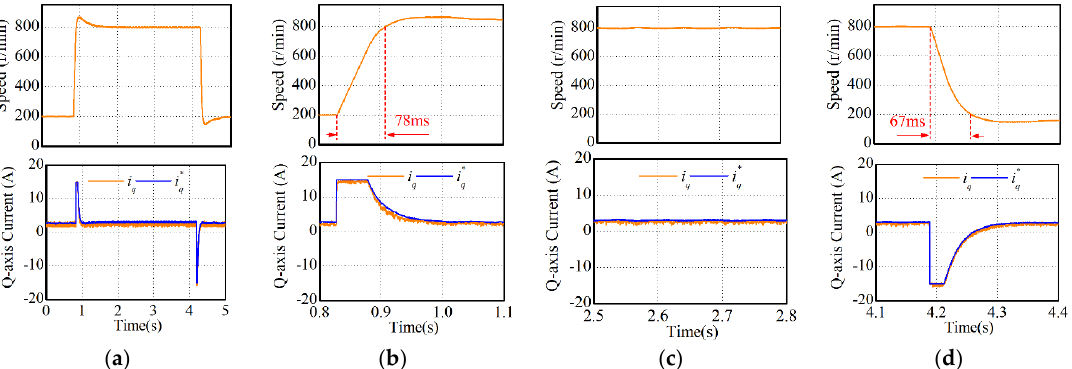
Figure 12. Speed response with under-voltage measurement ( a ) 0 – 5 s, ( b ) 1.0 – 1.3 s, ( c ) 2.5 – 2.8 s, ( d ) 4.0~4.3 s.